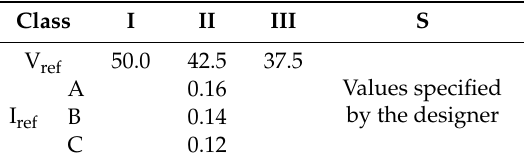
Table 1. Wind turbine class according to IEC 61400-1 Ed.3